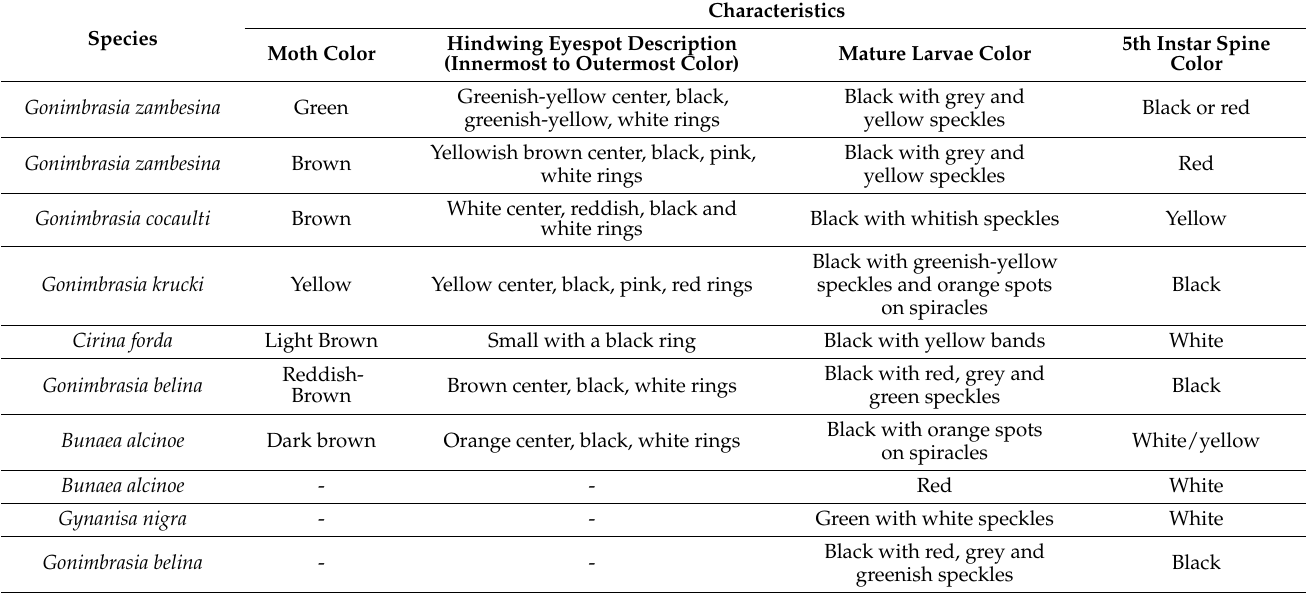
Table 1. Morphological characteristics of saturniids collected in Kenya.